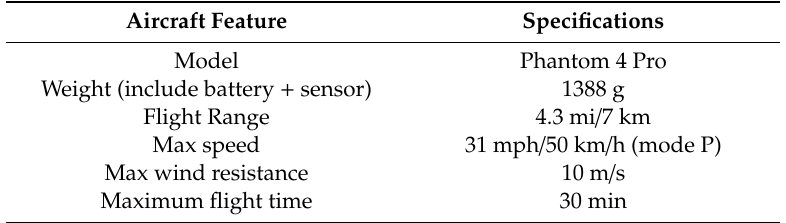
Table 1. Technical specifications of the multirotor UAV platform used.